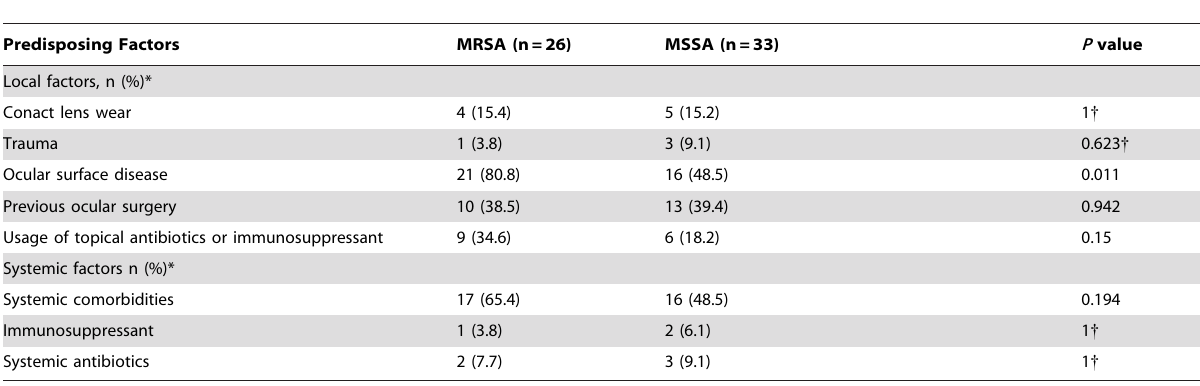
Table 3. Predisposing factors for MRSA and MSSA keratitis.